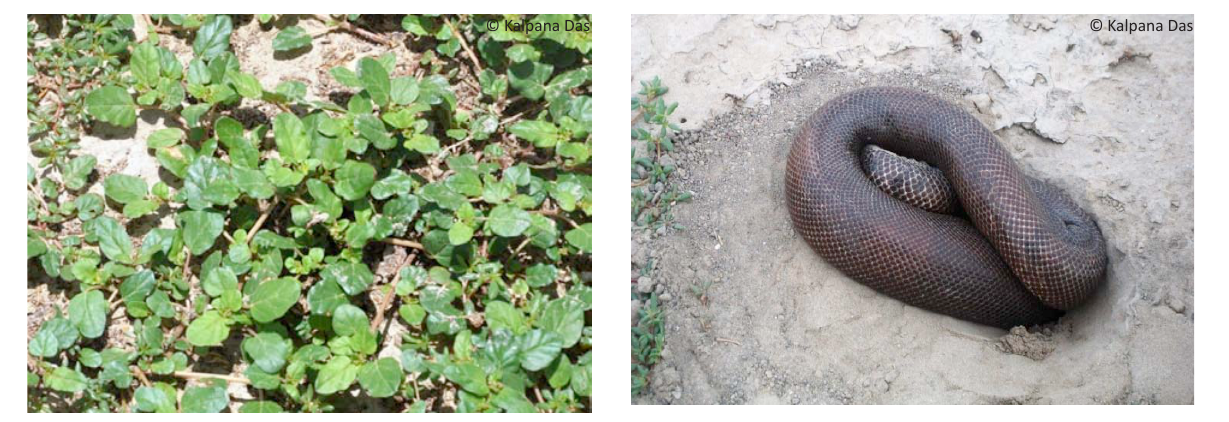
Species Cyperus rotundus